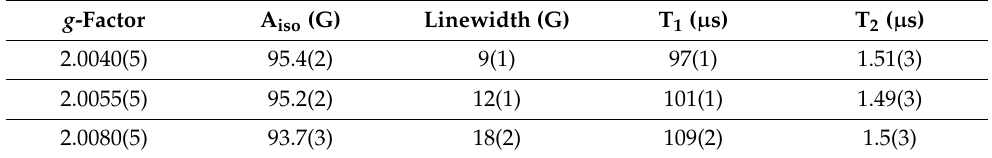
Table 2. The main spectroscopic and relaxation characteristics of Mn 2+ ions in TCP for 0.001MnTCP extracted at T = 50 K. The relaxation times were measured as a functions of magnetic field B 0 from 33,380 G to 34,000 G.